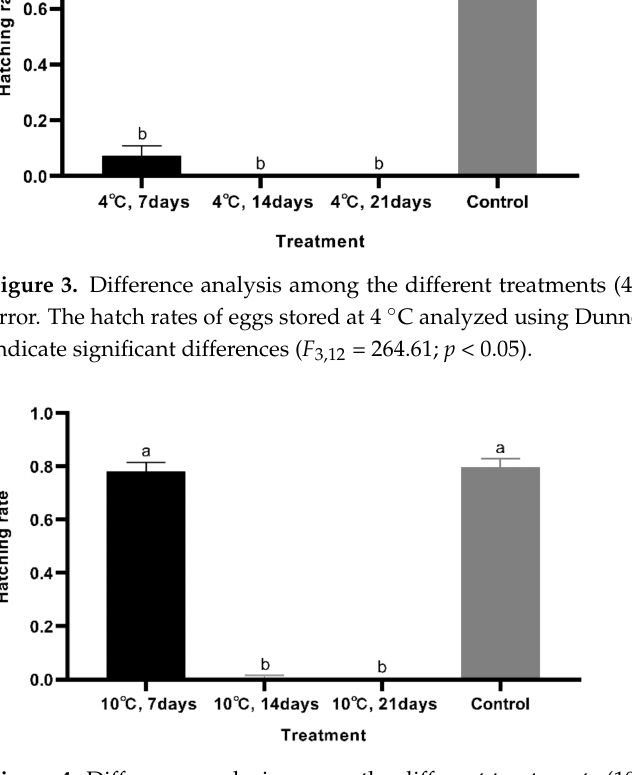
Figure 4. Difference analysis among the different treatments (10 ◦ C). Bars represent the standard error. The hatch rates of eggs stored at 10 ◦ C were analyzed using Dunnett T3. Different letters on the bars indicate significant differences ( F 3,12 = 378.74; p <